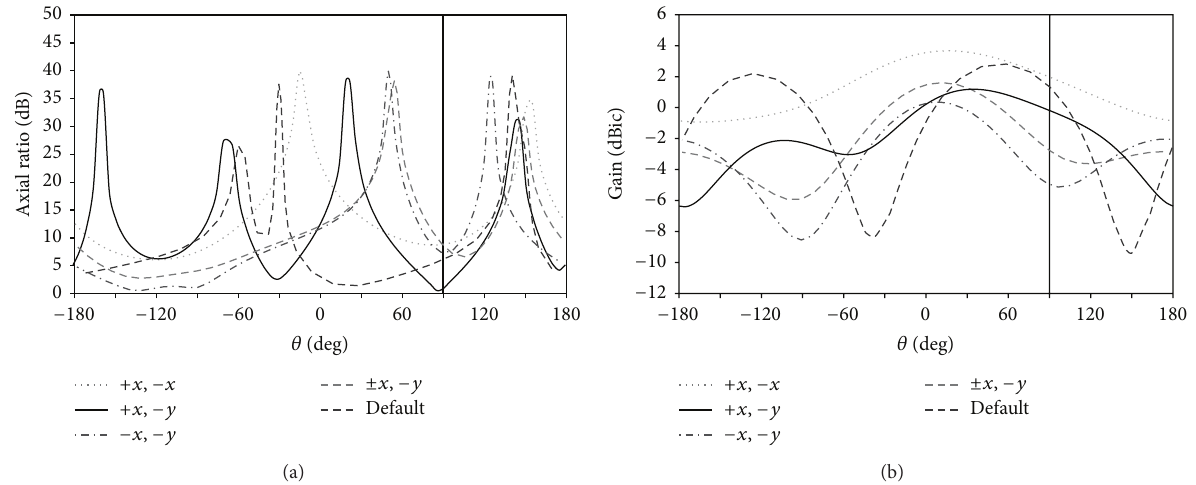
Figure 12: Simulated results of (a) AR pattern and (b) antenna gain in y-z plane at 925 MHz as a function of the ground plane size by g = 20 mm ( 𝜙 = 90 ∘ ).